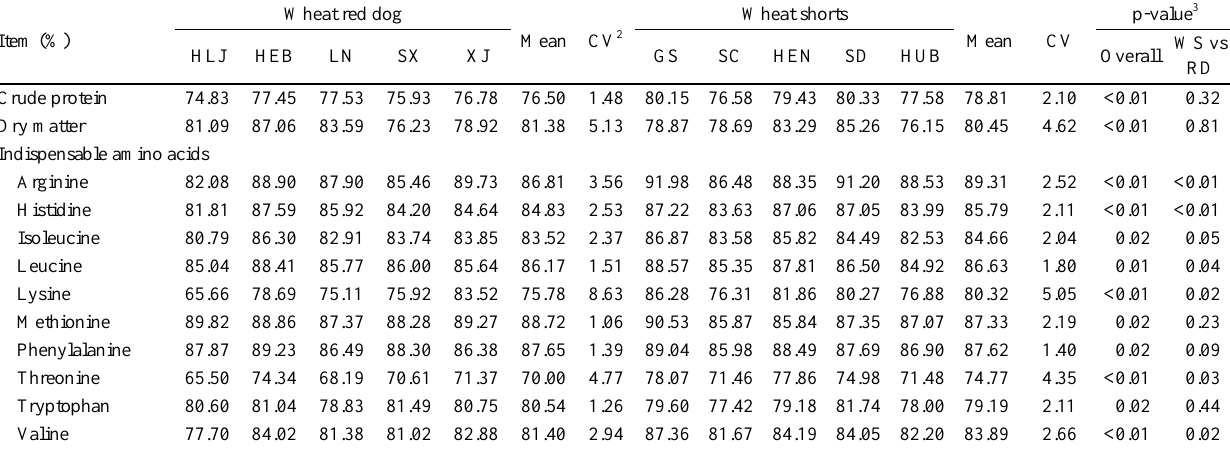
Table 9. Apparent ileal digestibility (%) of dry matter, crude protein and amino acids in wheat shorts and red dog tested in Exp. 2 (% as